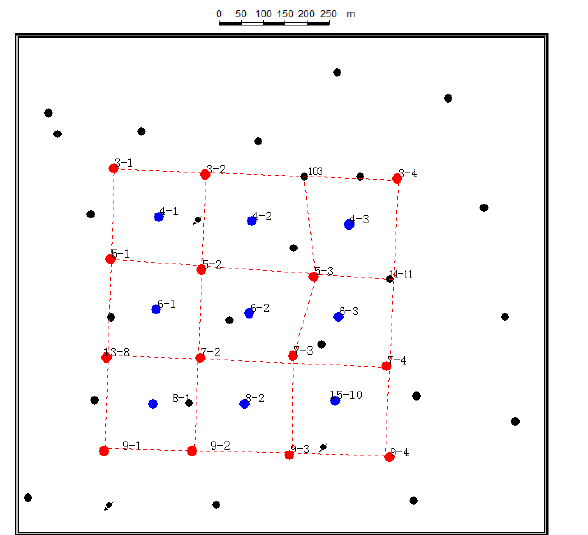
Figure 1—Well location in test area. The red dots represents producer, and the blue dots are